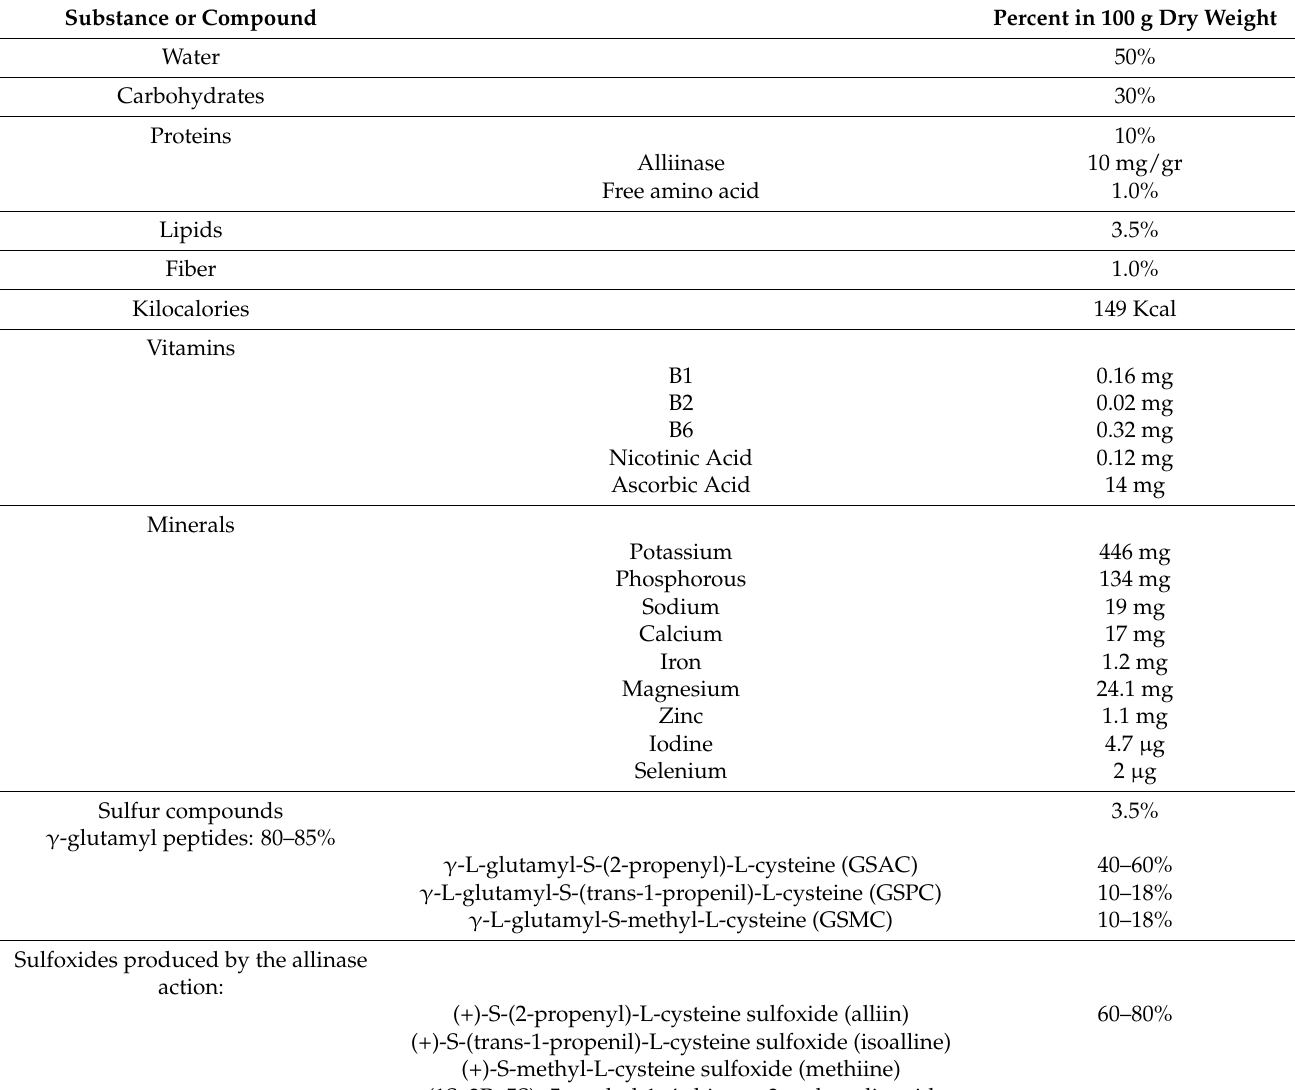
Table 2. Composition of raw garlic (Allium